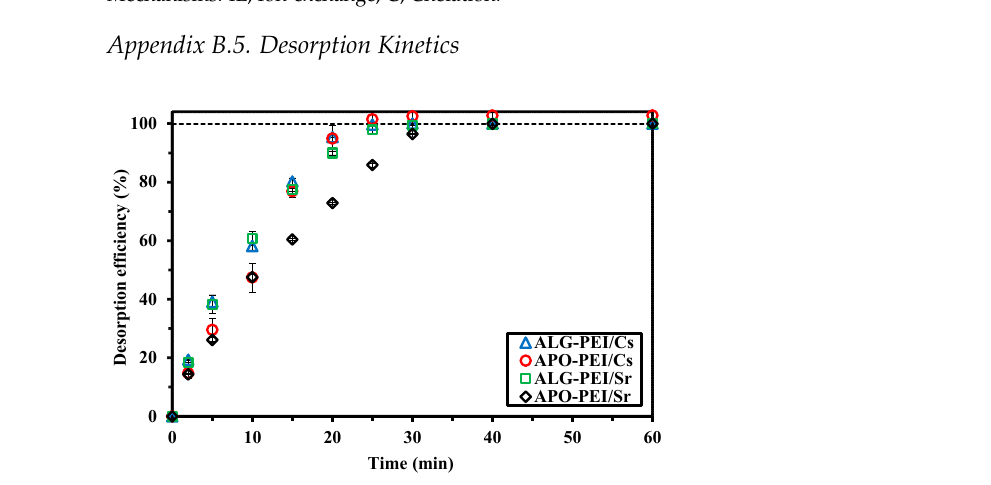
Figure A18. Cs(I) and Sr(II) desorption kinetics for ALG-PEI and APO-PEI sorbents: case of mono- component systems (metal-loaded samples collected at equilibrium from the relevant kinetics; SD: 2.67 g L − 1 ; eluent: 0.2 M HNO 3 ; v: 210 rpm; T: 21 ± 1 °C).